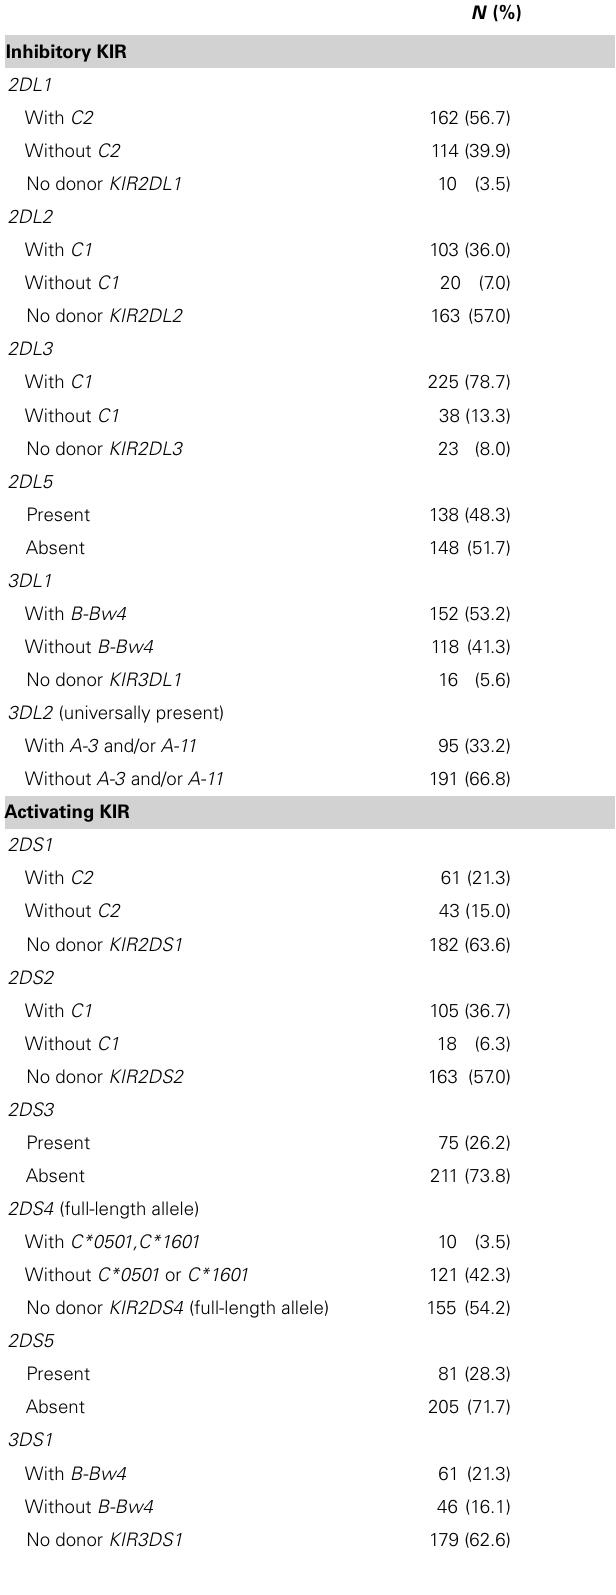
Table 2 | Donor KIR genes, by presence of HLA ligand in shared genotype of donor and recipient pair ( N =